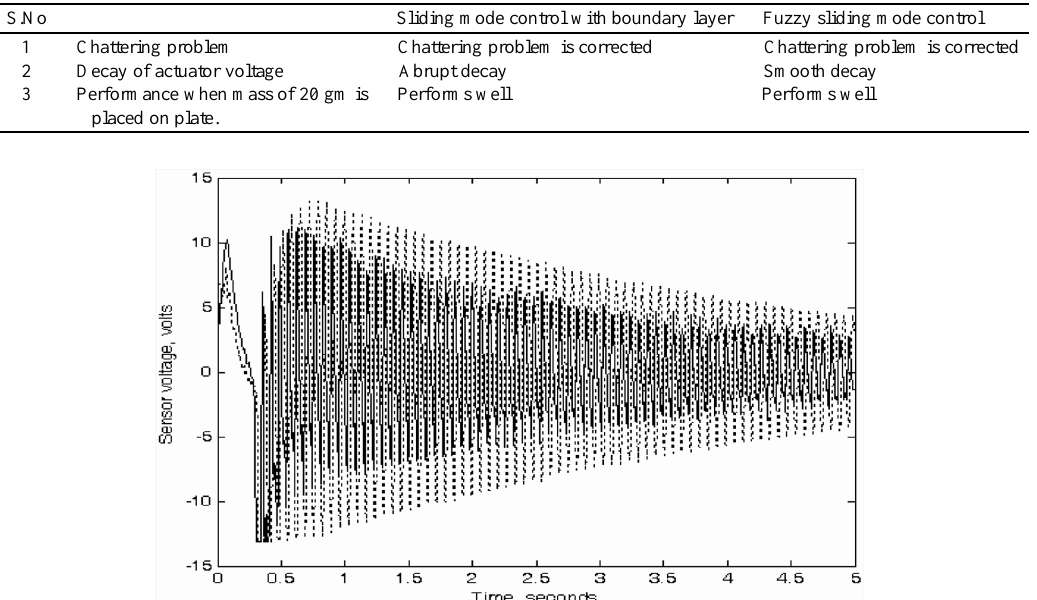
Table 4 Comparison of performance of SMC with boundary layer with fuzzy